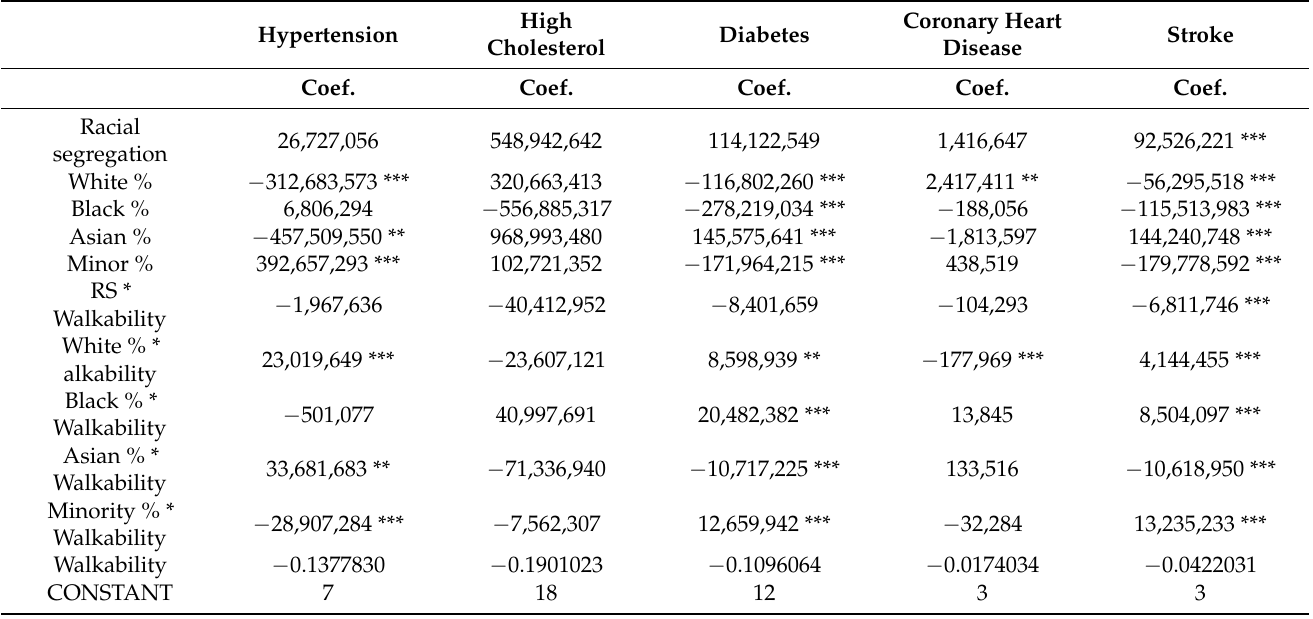
Table 4. Spatial regression model results of health outcomes, racial segregation, and walkability in the Chicago metropolitan area. Coronary Heart High Stroke Diabetes Hypertension Disease Cholesterol Coef. Coef. Coef. Coef.